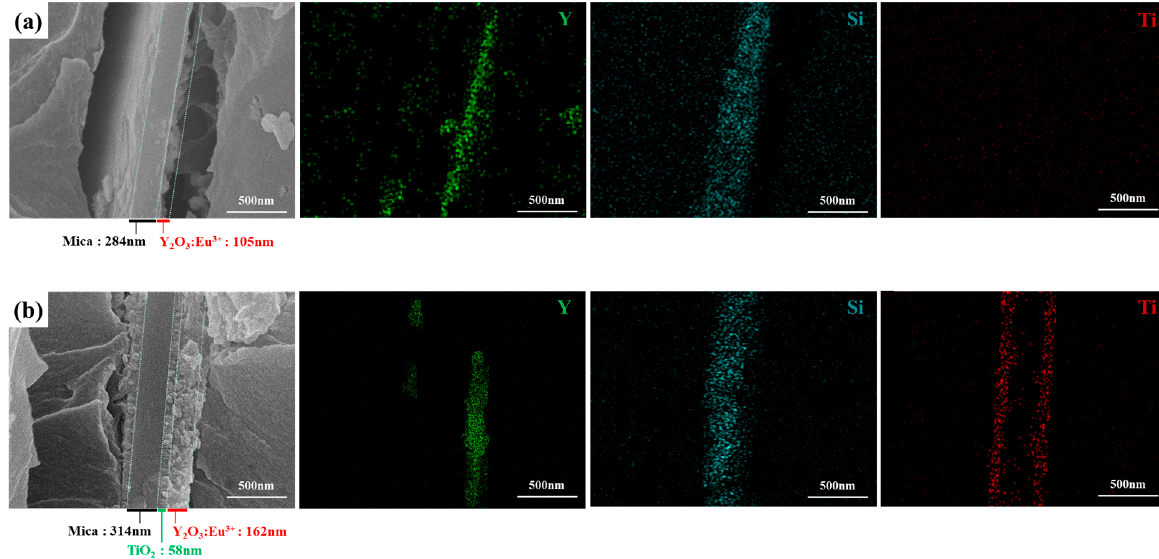
Figure 11. Cross-section FE-SEM images and EDS mapping of Y, Si and Ti elements in ( a ) Y 2 O 3 :Eu@MF (10 wt%) and ( b ) Y 2 O 3 :Eu@TMF (20 wt%).